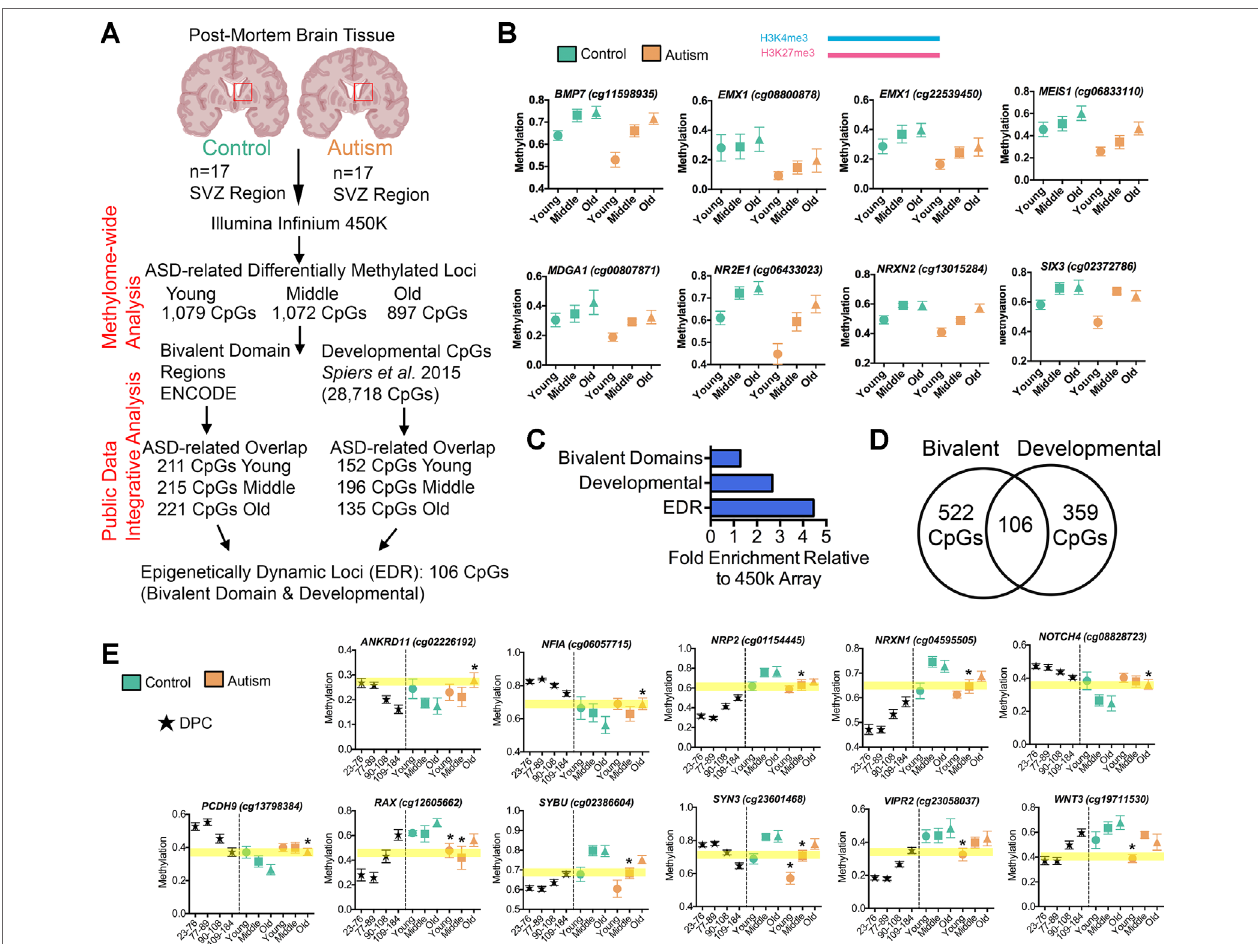
FIgURE 4 | Altered intragenic DNA methylation in ASD occurs in bivalent chromatin domain regions and at CpGs that are developmentally dynamic in fetal brain. (A) Flow chart of integrative analysis of 450k array data. (B) Autism-associated DML located in a human H1-hESC bivalent domain containing both H3K4me3 (blue bar) and H3K27me3 (pink bar). Typically developing control (green) and autism-diagnosed (orange) mean ± SEM methylation levels presented for DML of related genes by age group. Gene symbol and 450k CpG site indicated above plot. (C) Enrichment of autism-associated DML observed in bivalent domains, developmental regions, and EDRs relative to all loci on the 450k array. (D) Venn diagram showing the overlap of autism-associated DML that are bivalent domains and developmentally dynamic in fetal brain. (E) Autism-associated DML in developmentally regulated regions of the genome. The prenatal human brain days post conception of Spiers et al. (2015) (black stars), typically developing control (green), and autism-diagnosed (orange) mean methylation ± SEM presented for DML of related genes by age group. Gene symbol and 450k CpG probe ID are indicated above graphs. Yellow highlighted region displays the level of methylation that the autism-associated DML is delayed. *, denotes significant methylation difference at P < 0.05 between control and autism